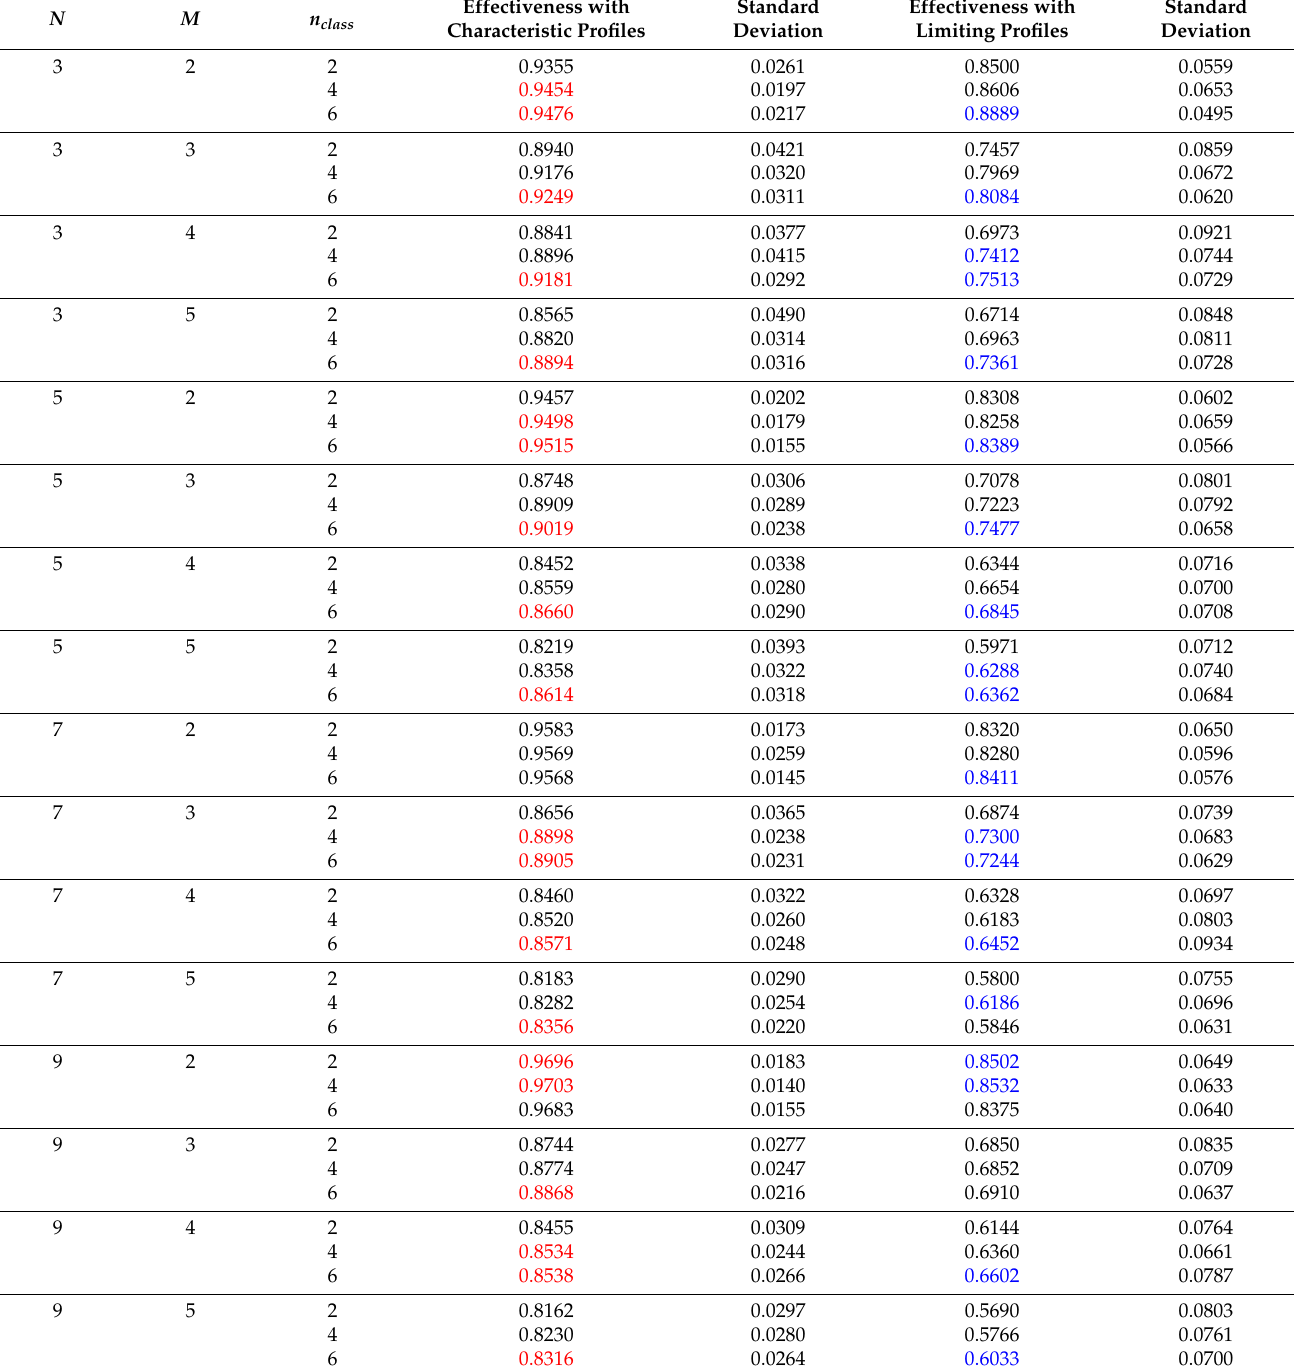
Table 2. Out-of-sample effectiveness of both sorting methods using a reflexive relation S , considering a different number of criteria, classes, and reference actions per